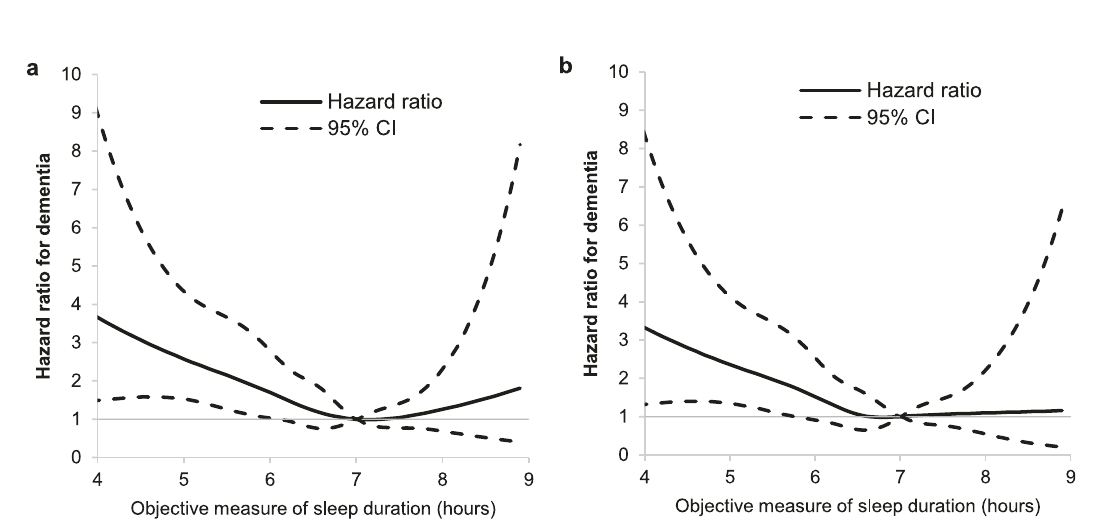
Fig. 2 Association of objectively assessed sleep duration (2012 – 2013, N cases/ N total = 111/3888) with incident dementia over a mean follow-up of 6.4 (SD = 1.0) years: accelerometer sub-study. a The hazard ratio for dementia (black plain line) with the corresponding 95% con fi dence interval (black dotted line) as a function of sleep duration from a Cox regression adjusted for age (timescale), sex, ethnicity, education, marital status, alcohol consumption, physical activity, smoking status, fruit and vegetable consumption, BMI, hypertension, diabetes, cardiovascular disease, GHQ depression, and CNS medications (Source data). b The hazard ratio for dementia (black plain line) with the corresponding 95% con fi dence interval (black dotted line) as a function of sleep duration from a Cox regression using inverse-probability weighting to account for missing data and adjusted for age (timescale), sex, ethnicity, education, marital status, alcohol consumption, physical activity, smoking status, fruit and vegetable consumption, BMI, hypertension, diabetes, cardiovascular disease, GHQ depression, and CNS medications (Source